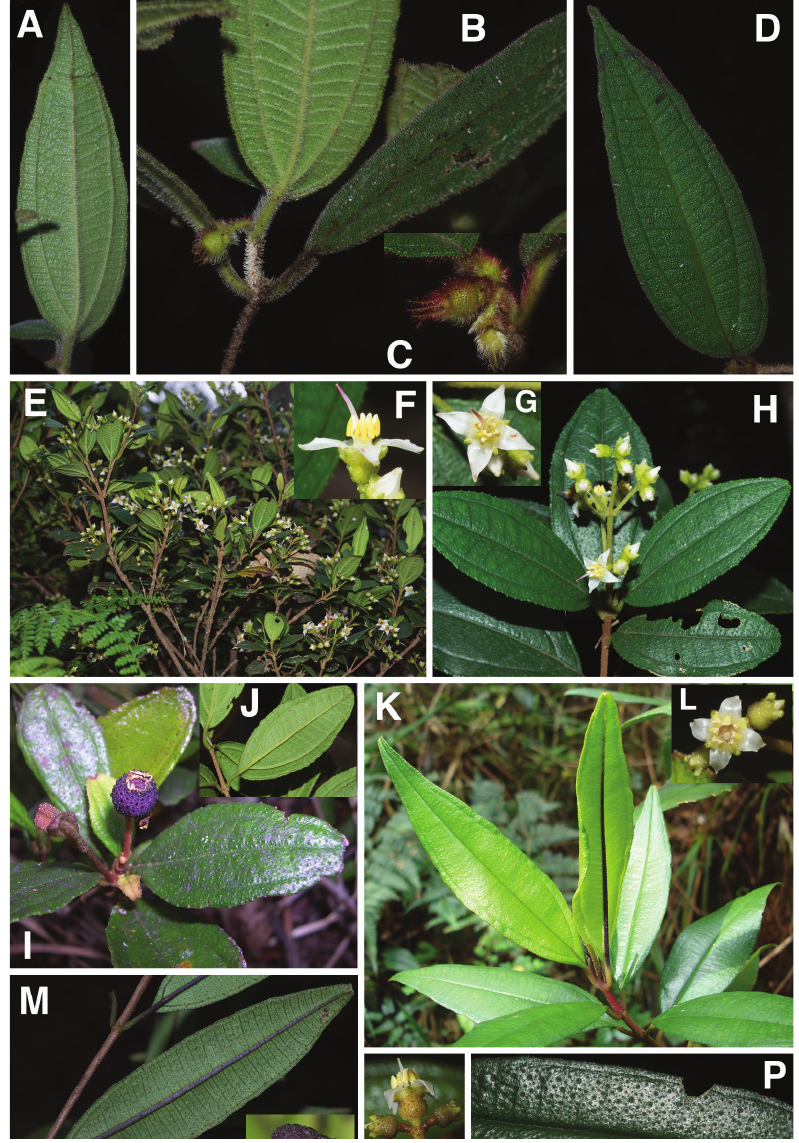
Figure 9. Photographs of Miconia jashaferi ( A–D ), M. norlindii ( E–J ), and M. granulata ( K–P ) . A Abaxial leaf surface B habit of M. jashaferi showing pendant infloresence C close-up of immature fruit showing long clayx lobes D adaxial leaf surface (all from Michelangeli 2284 ) E habit of M. norlindii F close-up of flower, side view G close-up of flower, frontal view H close-up of infloresence (all from Michelangeli 2213 ) I mature fruit ( Bécquer s.n. ) J leaf abaxial surface ( Michelangeli 2213 ) K habit of M. granulata ( Bécquer HFC-82266 ) L close-up of flower ( Michelangeli 2269 ) M leaf abaxial surface, showing purple primary vein ( Michelangeli 2265 ) N mature fruit ( Michelangeli 2269 ) O close-up of branch of inflorescence ( Michelangeli 2269 ) P leaf adaxial surface showing reduced bulla-based hairs ( Michelangeli 2265 ). Photos I & K taken by E. Bécquer and A–H , J , & L–P by F.